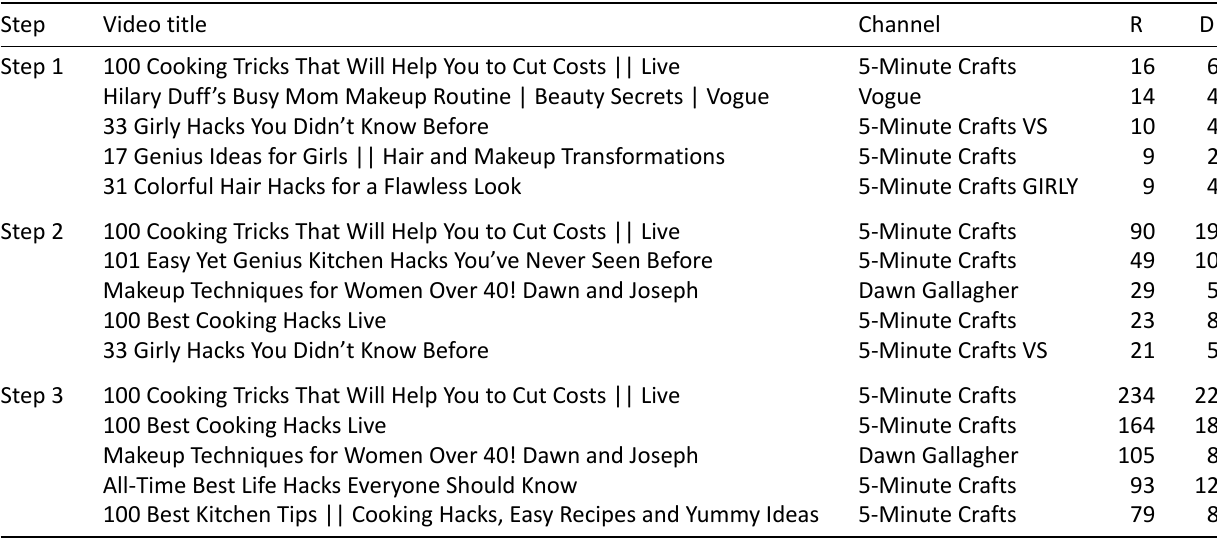
Table 6. Top five videos recommended for “beauty” at each